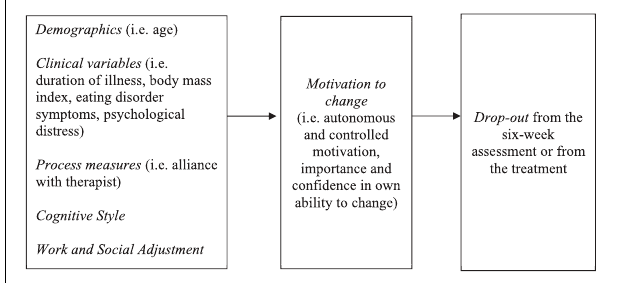
FIGURE 1 | Theoretical model. This figure describes hypothesized relationships between the variables investigated.